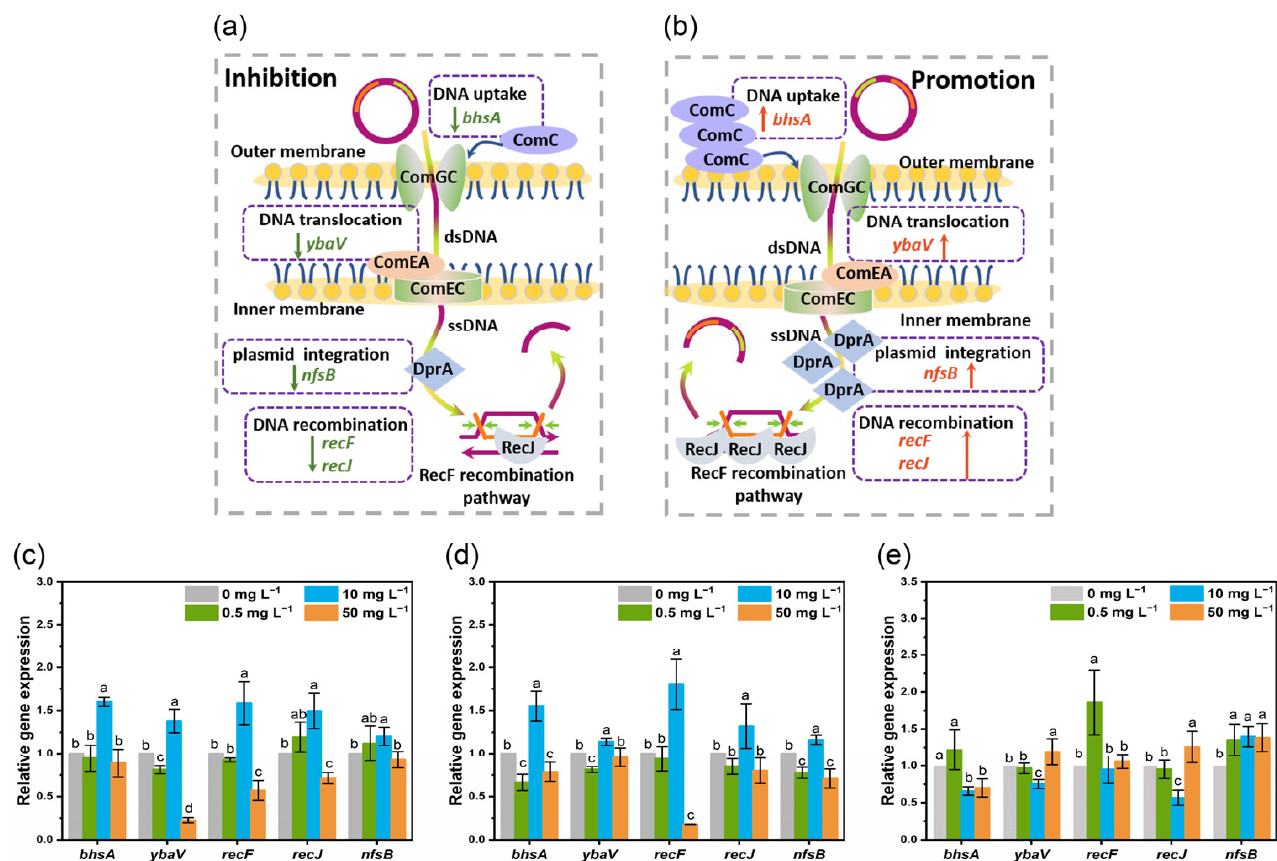
Figure 5. Effect of CeO 2 NPs on the gene expression related to transformation. Schematic plot for plasmid-borne ARGs uptake and integration mediated by CeO 2 NPs ( a , b ). Relative expression of transformation-related genes regulated by CeO 2 NPs (0, 0.5, 10, and 50 mg L − 1 ) in System 1 ( c ), System 2 ( d ), and System 3 ( e ). Lowercase letters represent the statistical significance among different concentrations of CeO 2 NPs.